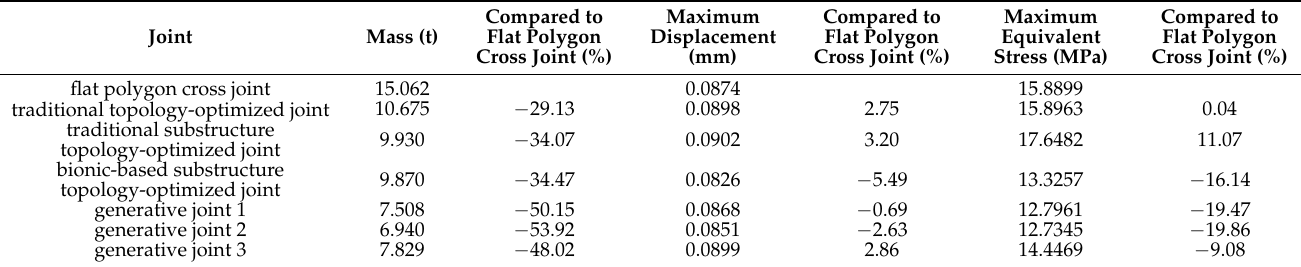
Table 2. Comparison of the generative joints and other joints.